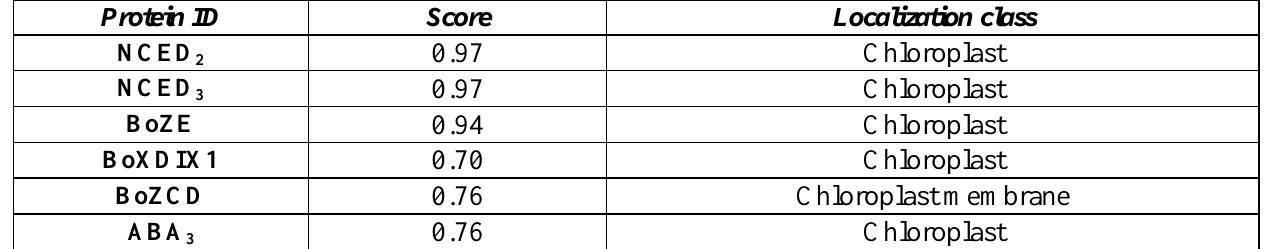
proteins and their correlated 2/3